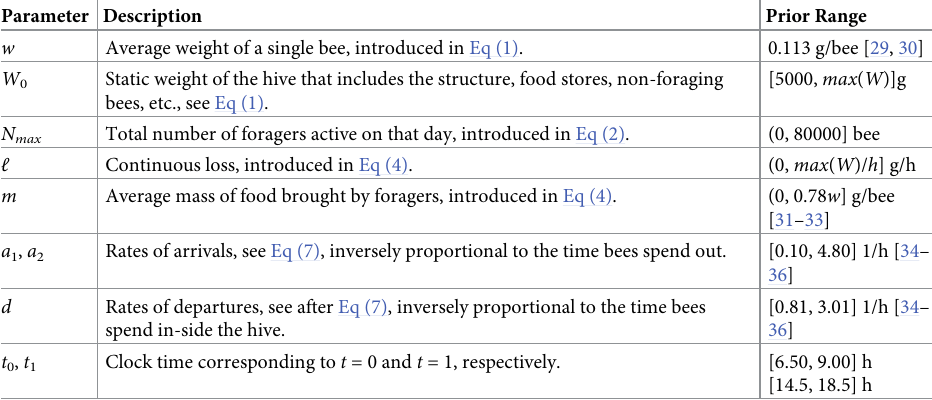
[5000, max ( W )]g [31–33] 36] [0.81, 3.01] 1/h [34– 36] [14.5, 18.5] h